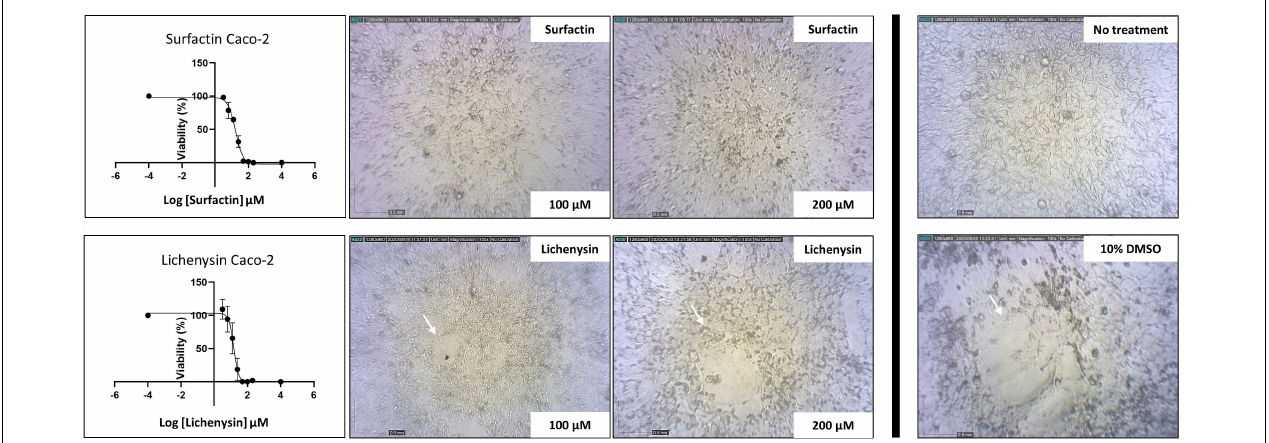
FIGURE 7 | Toxicity of lichenysin and surfactin toward human Caco-2 cells. Caco-2 cells were seeded (2 × 10ˆ5 cells/ml) in 96 wells-plates and exposed to different lichenysin and surfactin concentrations (only 100 and 200 µ M are shown; in log 10 scale = 2 and 2.3 µ M, respectively). No-treatment cells were the negative control and 10% DMSO was used as a control for cell death. Cell viability was monitored for 72 h, microscopic pictures of cell disruption for lichenysin after 24 and 72 h are shown. The IC 50 for lichenysin is 16.6 µ M (= ∼ 16.6 µ g/ml), in log 10 scale = 1.22 µ M; and for surfactin is 23.5 µ M (= ∼ 25.5 µ g/ml), in log 10 scale = 1.37 µ